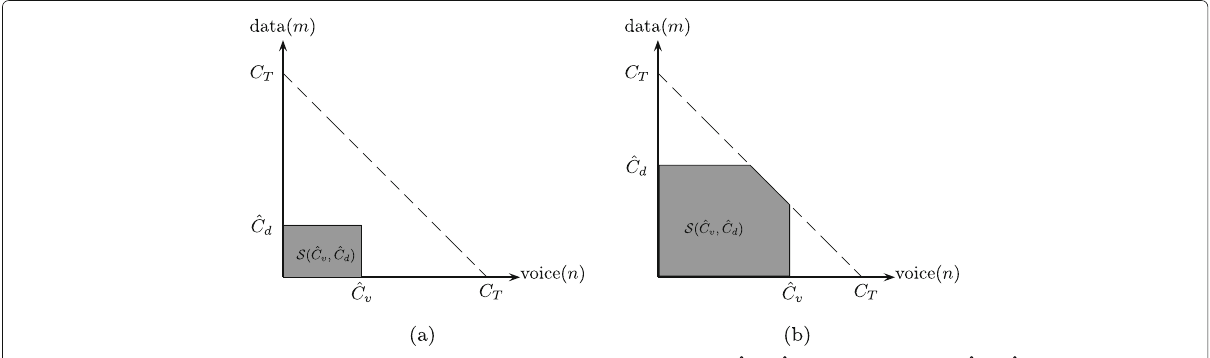
Fig. 2 Examples of the allowed states from the 2D M/M/m/m Markov chain. a Case where ˆ C v + ˆ C d ≤ C T . b Case where ˆ C v + ˆ C d > C T